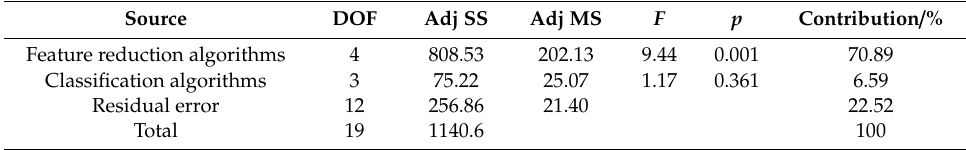
Table 5. ANOVA results for the classification accuracy of sweet corn seed